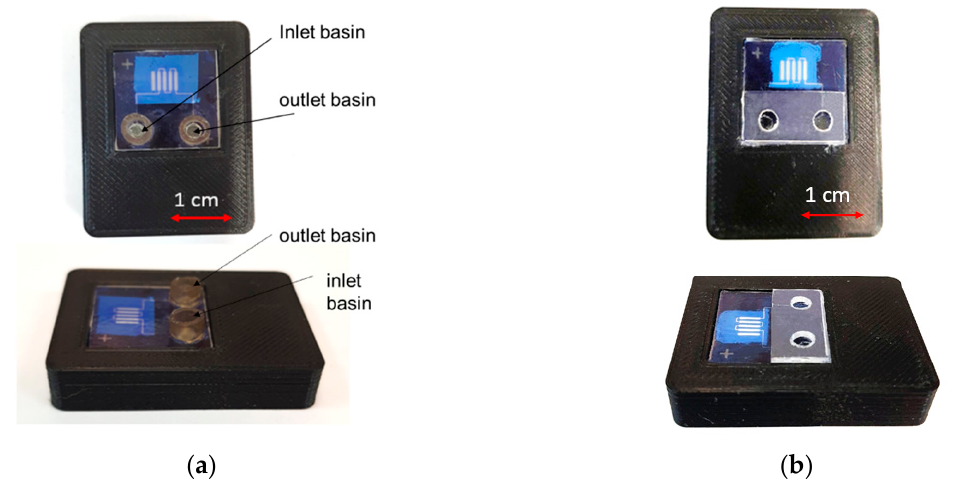
Figure 11. The samples of microfluidic biosensor systems in the assembly: ( a )—with separate polypropylene input ports; ( b )—with input ports made of a solid PMMA construction.